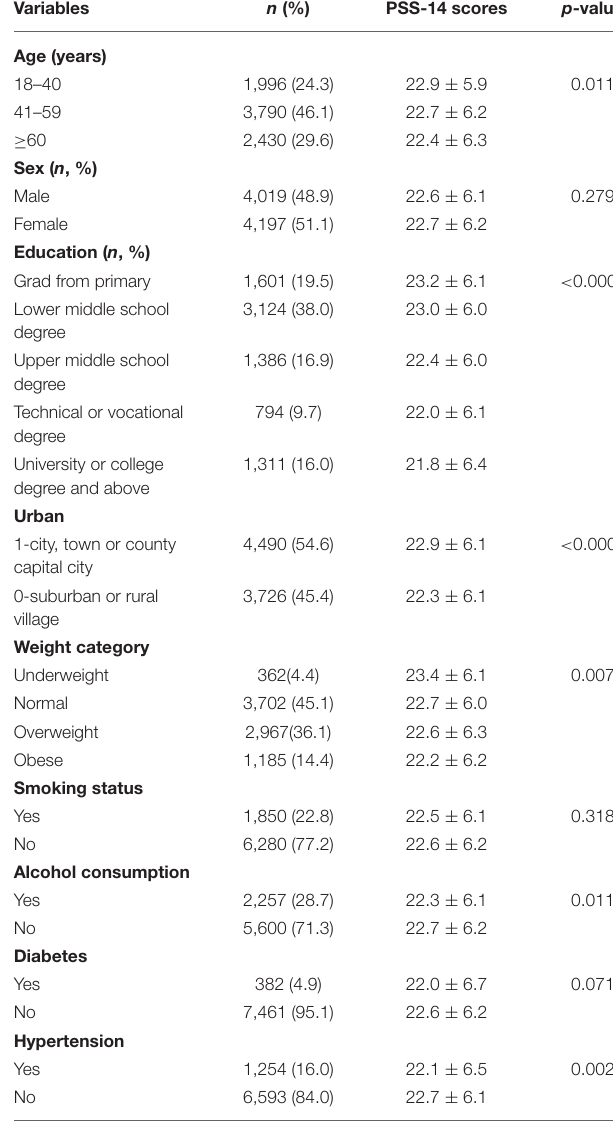
details are presented in Table 3 . The logistic regression